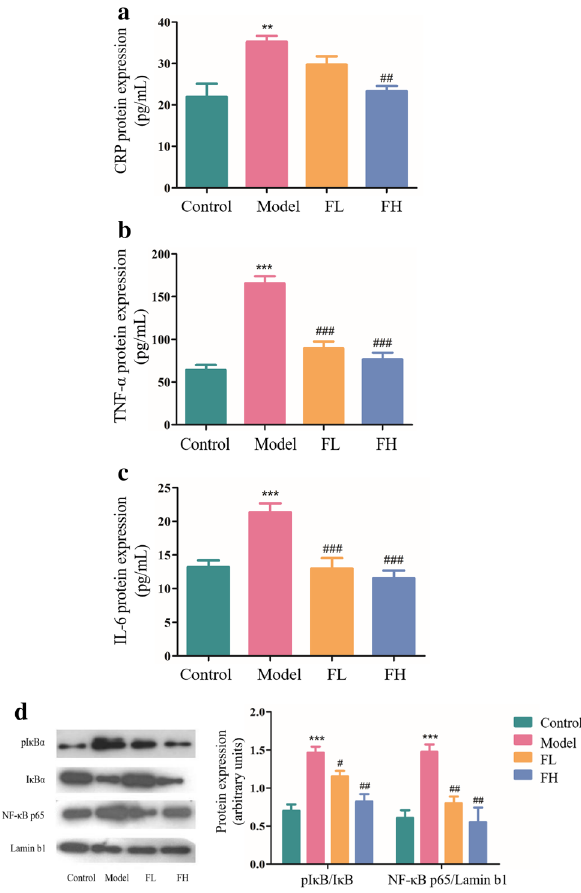
Figure 4. FGF-21 inhibits inflammation in thrombotic mice. Mice were administered Ca (3 mg/kg) via intraperitoneal injection and LPS (50 μg/kg) via the tail vein 16 h later. Then, FGF-21 was administered to the mice once daily for 5 days. Control: normal control; Model: Ca-LPS-induced thrombosis mice; FL: thrombosis mice treated with low dose FGF-21 (5 mg/kg); FH: thrombosis mice treated with high dose FGF-21 (10 mg/ kg); CRP: c-reactive protein; TNF-α: tumor necrosis factor-α; IL-6: interleukin 6. ( a - c ) ELISA of CRP, TNF-α, IL-6 expression in the serum. ( d ) Western blot analysis of phospho-IκB and p65 expression in mice. For all bar graphs, data are expressed as the mean±SD (n = 6). One-way ANOVA was used for multiple group comparisons, followed by Student’s two-tailed t test. ** p < 0.01, *** p < 0.001 compared with the control; # P < 0.05, ## P < 0.01, ### P < 0.001 compared with the